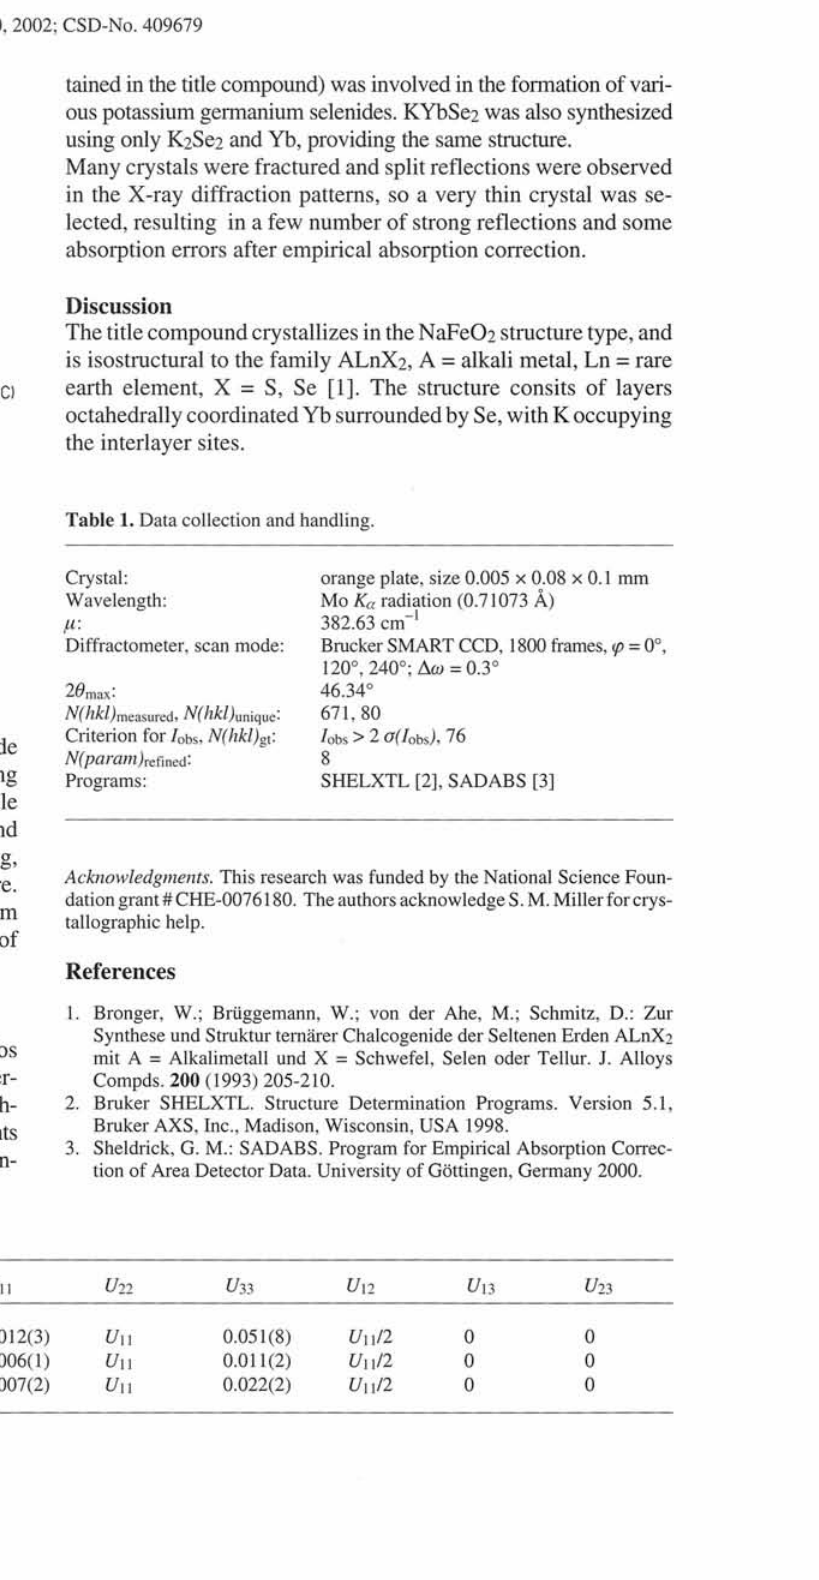
Table 2. Atomic coordinates and displacement parameters (in